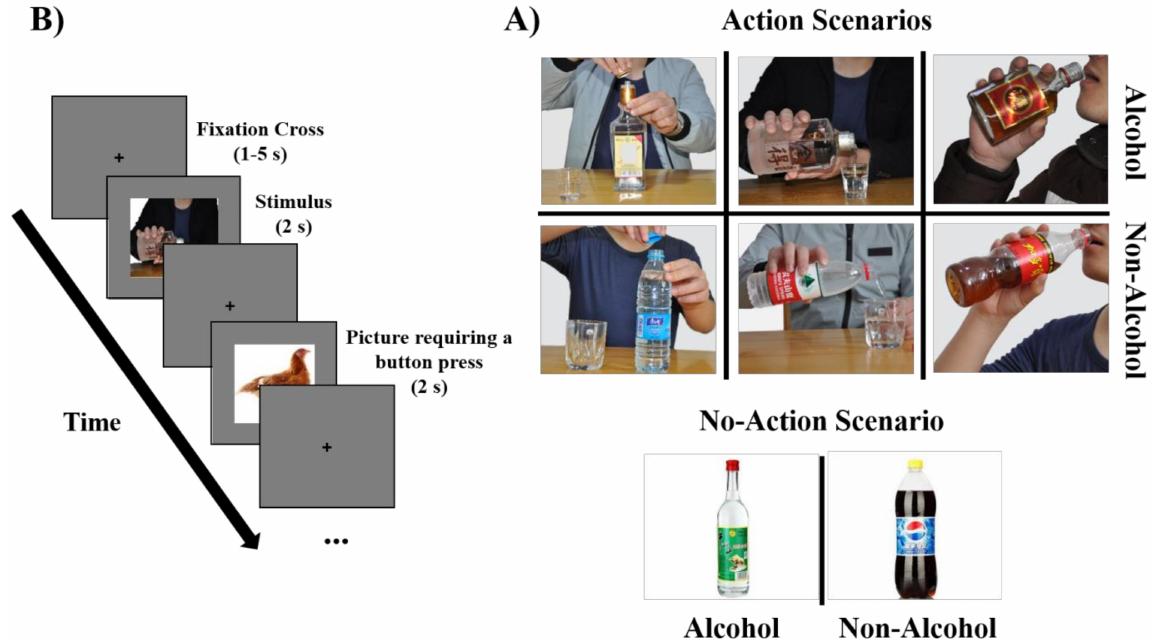
Figure 1. Experimental structure and design: ( A ) each experiment has two types of beverage cues (alcohol and matched non-alcohol with different scenarios) and animal cues. The design of the task was single trial, in which each trial contains a fixation cross presented for 1–5 s before the stimulus image of an alcohol or non-alcohol cue was presented for 2 s. The animal picture was used to require pressing a button to keep the subject’s attention on the task. ( B ) sample task stimuli. The top six images show examples of alcohol/non-alcohol cues as a function of the action scenario. The bottom two images show examples of alcohol/non-alcohol cues as a function of the no-action